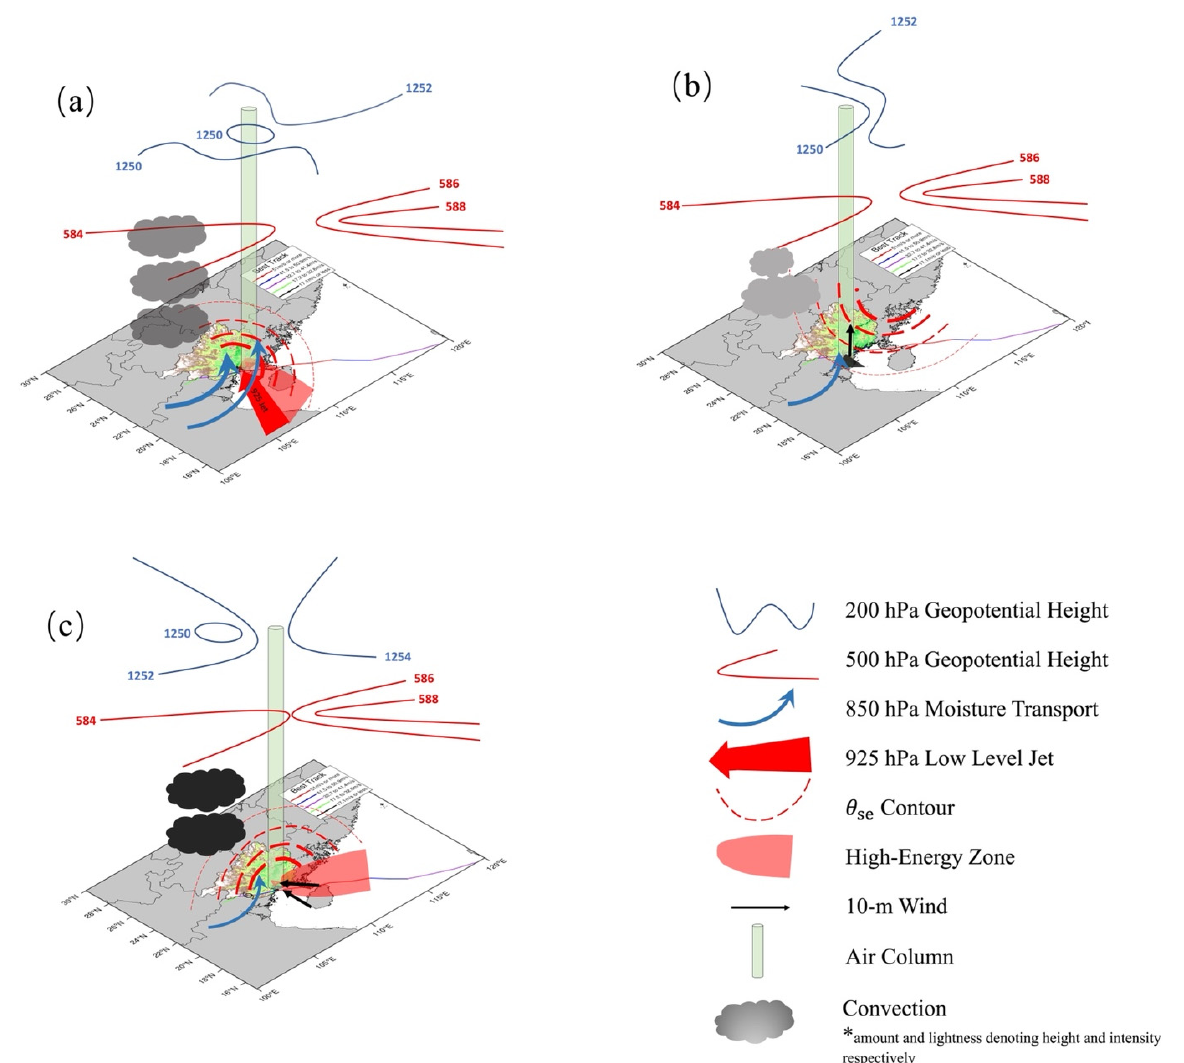
Figure 9. Schematics of conceptual models for ( a ) Hepu, ( b ) Fangcheng, and ( c ) Lingshan rainstorms caused by TC Rammasun.